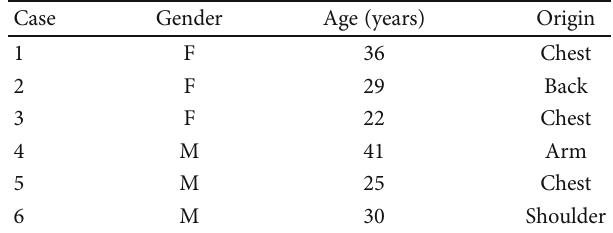
Table 1: Demographic data of keloid samples used in this study.